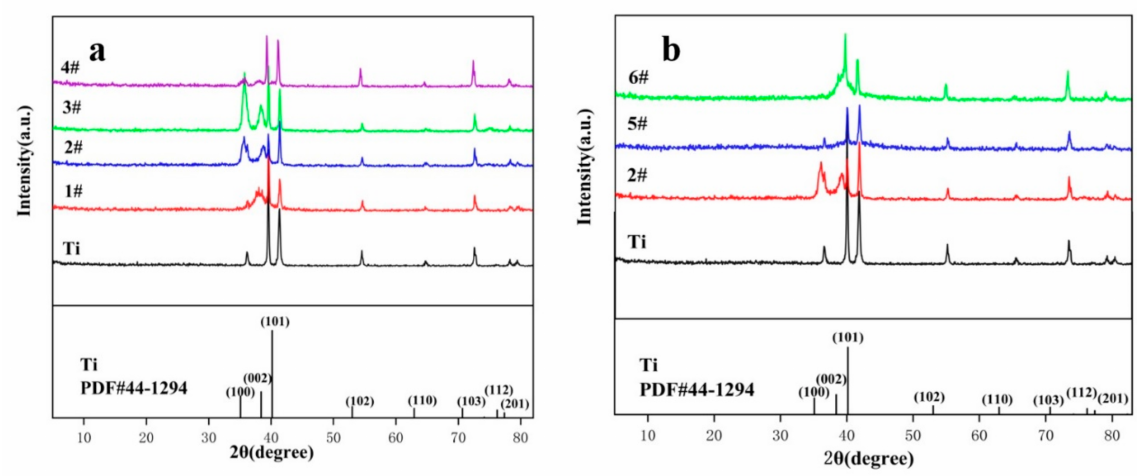
Figure 1. XRD pattern of Cu/Ti coating: ( a ) different bias voltage, ( b ) different number of cop- per sheets.